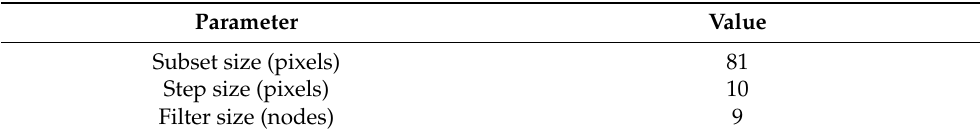
Table 4. Selected postprocessing parameters used for all tests analyzed in this work, based on VSG study performed on Test D. Parameter Value Subset size (pixels) 81 Step size (pixels) 10 Filter size (nodes) 9